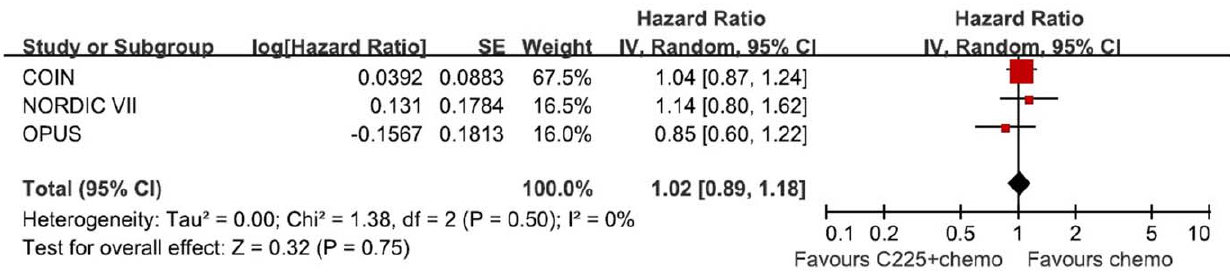
Figure 5. Randomized effect model on HR of OS in Cetuximab subgroup. The pooled HR of OS in cetuximab subgroup is symbolized by a solid diamond at the bottom of the forest plot and the width of which represents the 95% CI.